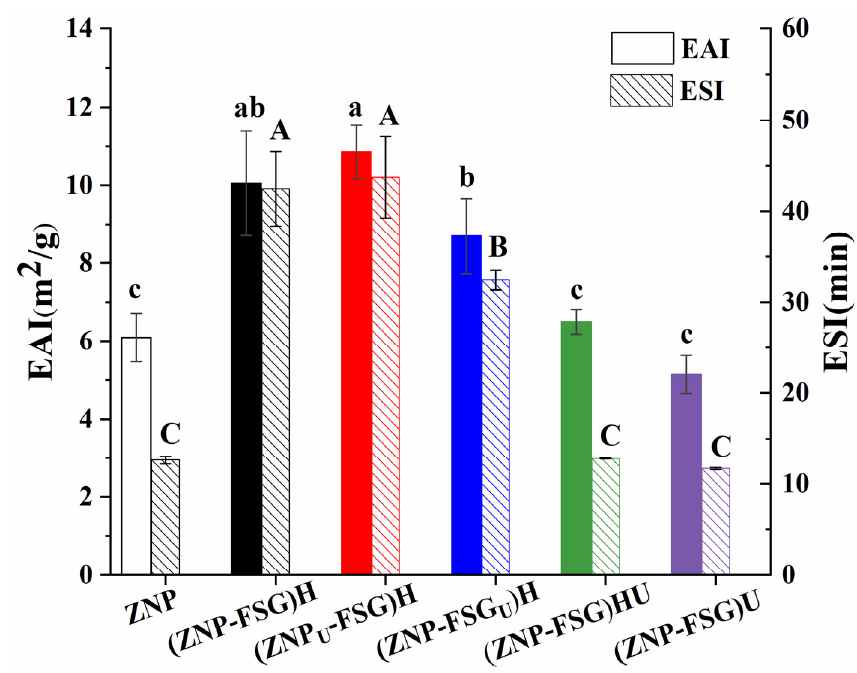
Figure 2. Emulsifying activity index (EAI) and emulsifying stability index (ESI) of emulsions stabi- lized by ZNP-FSG complexes subjected to various ultrasound and homogenization treatments.